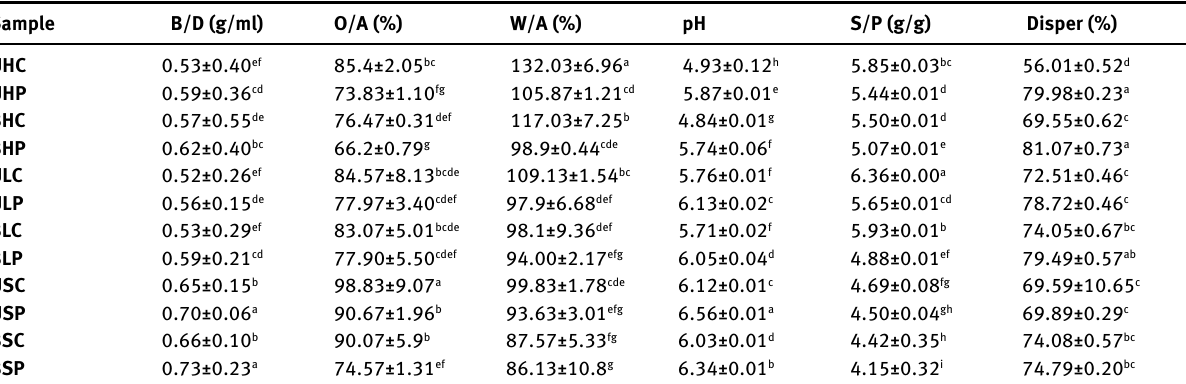
Table 3: Functional and physico-chemical properties of cardaba banana and plantain flour